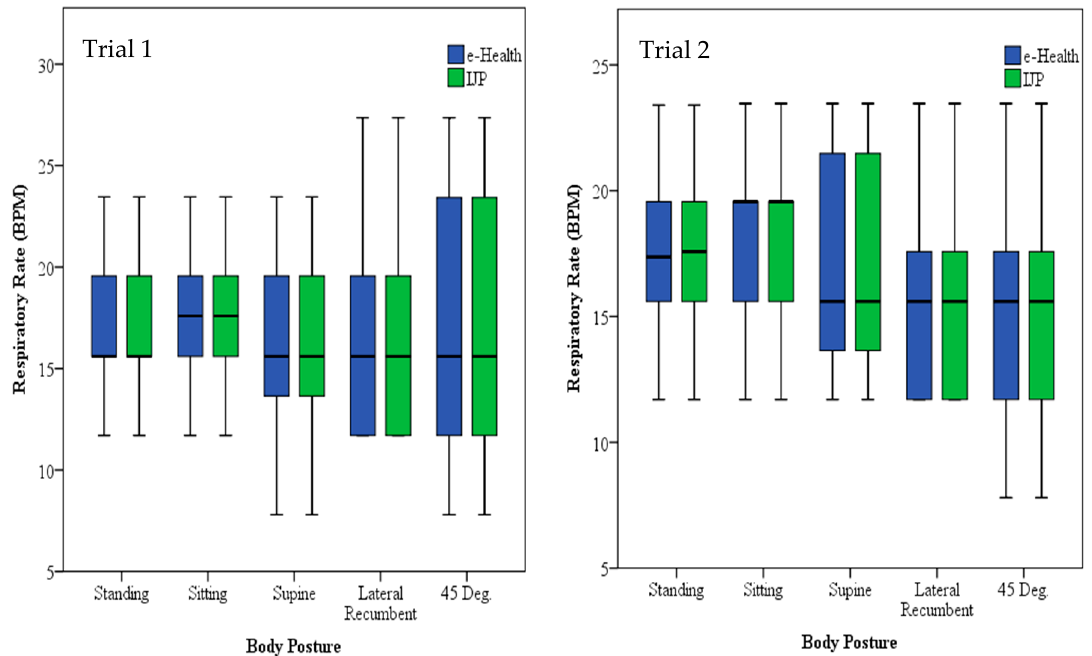
Figure 5. Box and whisker plots of the RR measured by the IJP sensor and the e-Health sensor for each trial at different body postures. The means are represented by the horizontal lines within the boxes while the first and third quartiles are represented by the boxes boundaries whereas the maximum and minimum values are represented by the whiskers.